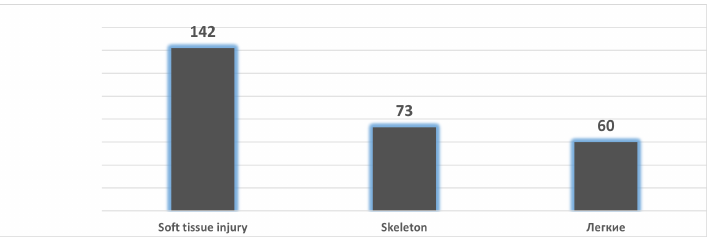
Figure 14. Extra-abdominal injuries in concomitant